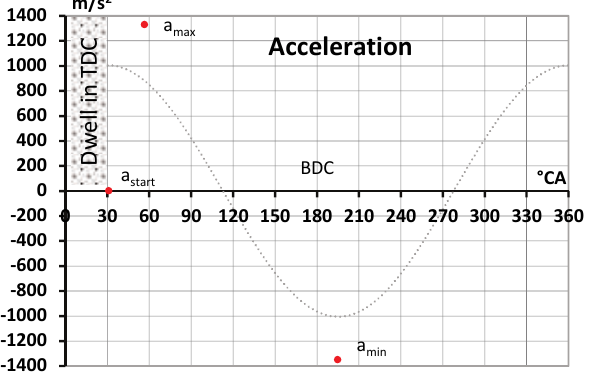
Fig. 6. Characteristic points of acceleration (red points) against the background of the base function (gray line) The smoothed run in the area of the point is obtained by the condition of the continuity of the third derivative